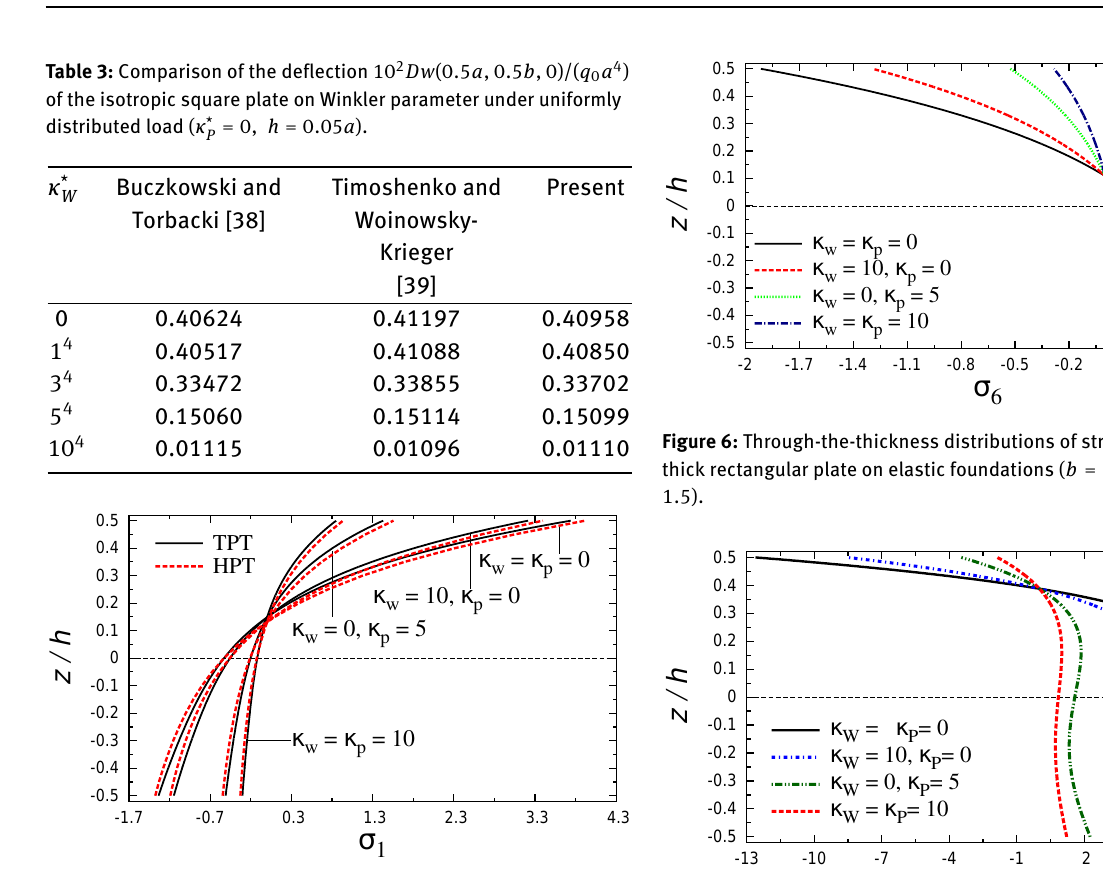
k . The transverse shear stresses σ 4 and σ 5 as well as the in- plane tangential stress σ 6 are decreasing with the